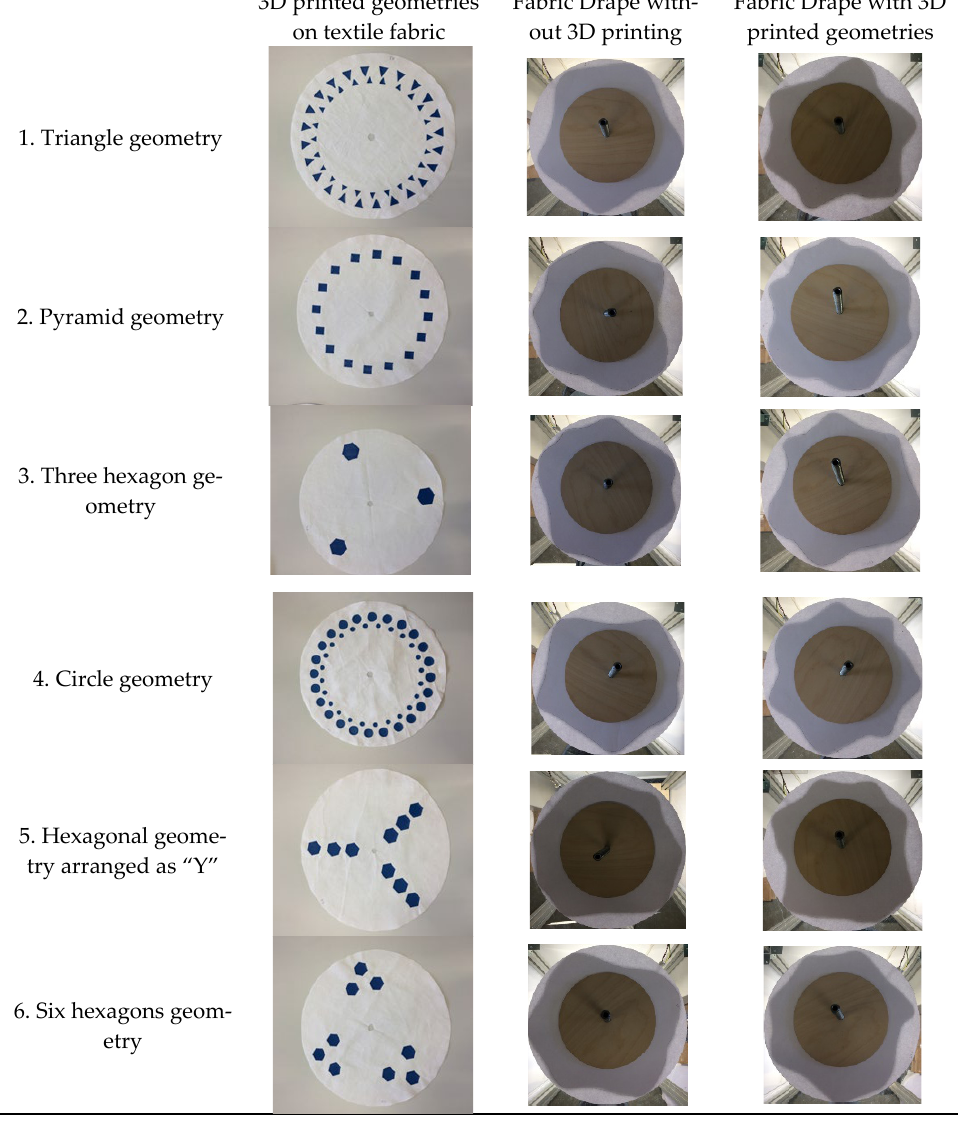
Figure 6. Drape of textile fabrics before (left images) and after 3D printing different geometries on them (right images).